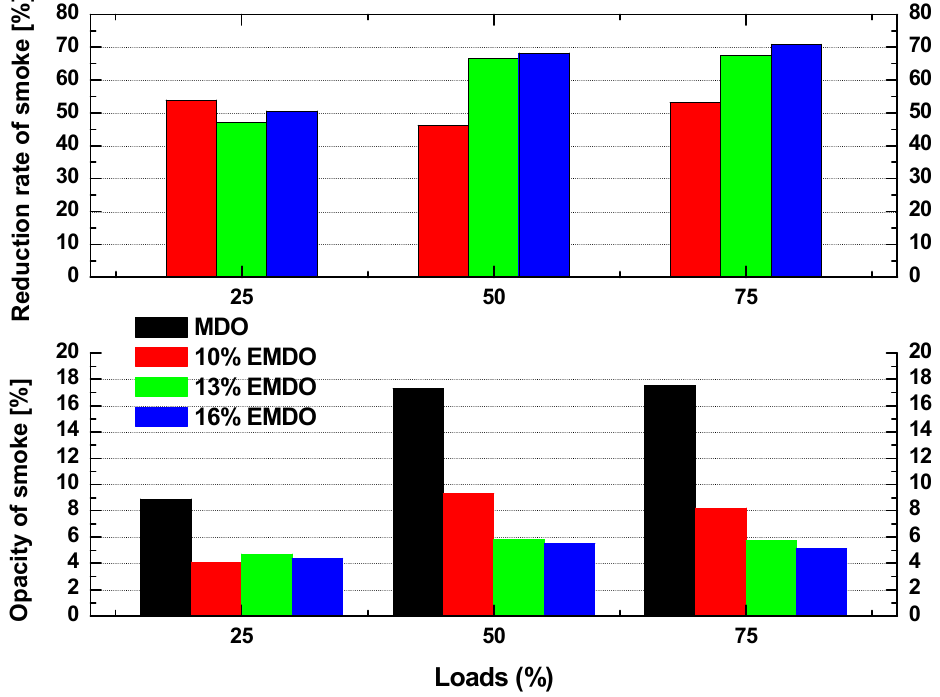
Figure 11. Smoke reduction characteristics according to load and water concentration of MDO.